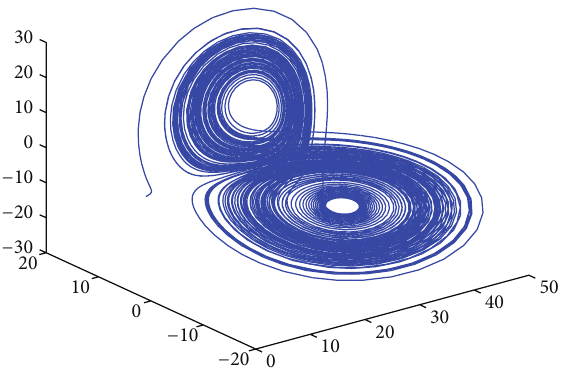
𝑦 = [𝑦 , 𝑦 , 𝑦 ] 𝑇 , 𝛿 = 𝑥 − 𝑦 = [𝛿 1 2 3 𝑦 , 𝑥 − 𝑦 ] 𝑇 , and |𝜖| = [|𝜖 2 3 3